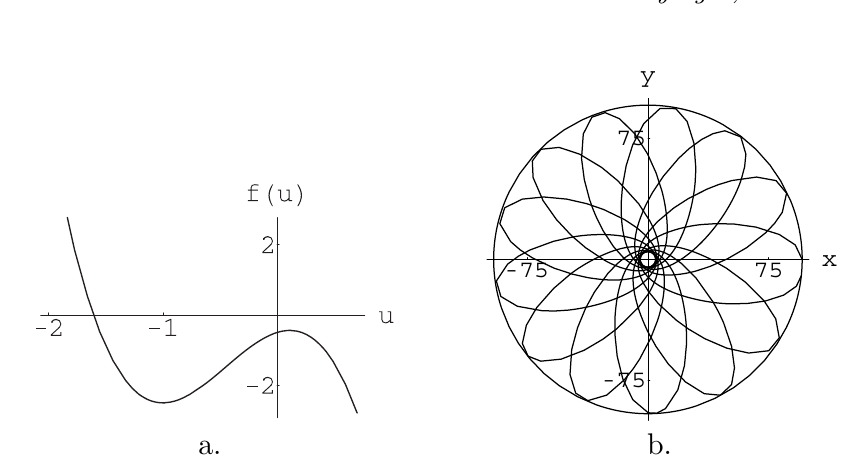
Fig. 8. (a) The cubic f ( u ) and (b) corresponding trajectory for the case D2. The graph is given for δ = − 3 , γ = 1 , σ = 5 , h = − 0 . 01